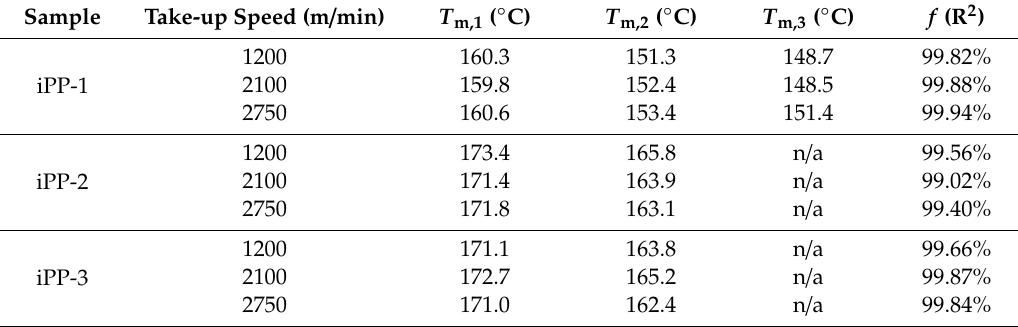
Table 8. Sub-peaks derived from DSC curves for as-spun iPP